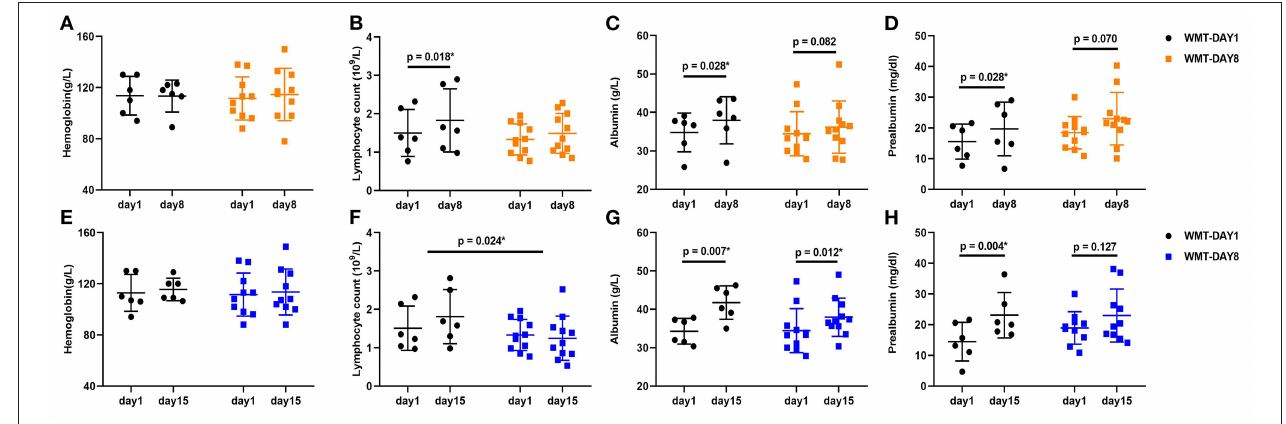
FIGURE 2 | Changes in nutritional parameters between day 1 and day 8, day 1 and day 15 in two groups. (A–D) Changes in hemoglobin, lymphocyte count, albumin, and prealbumin between day 1 and day 8 in group WMT-DAY1 and group WMT-DAY8, respectively. (E–H) Changes in hemoglobin, lymphocyte count, albumin, and prealbumin between day 1 and day 15 in group WMT-DAY1 and group WMT-DAY8, respectively. The distribution of values within each group at each timing is illustrated by mean and SD. In group WMT-DAY1, data of two patients at day 8 and another two patients at day 15 were unavailable. WMT, washed microbiota transplantation.